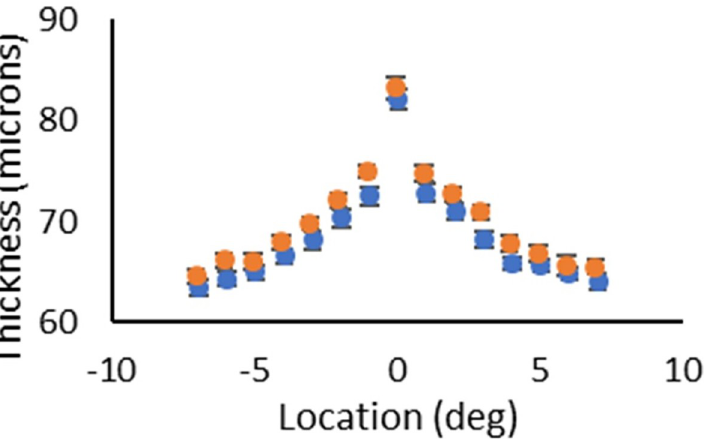
Fig 5. Thickness measurements of the domain ranging from the boundary between the RPE and CH to the ISOS junction. Location zero is the fovea, negative locations indicate degrees temporal to the fovea, and positive locations indicate degrees nasal to the fovea. Orange circles are the control subjects, and blue circles are the diabetic subjects. Control subjects were significantly thicker than the diabetic subjects at 1 deg temporal to the fovea and 3 deg nasal to the fovea. These data do not support the idea that diabetic subjects as a whole develop thicker deep retinal layers prior to clinical disease, for locations in the central retina.